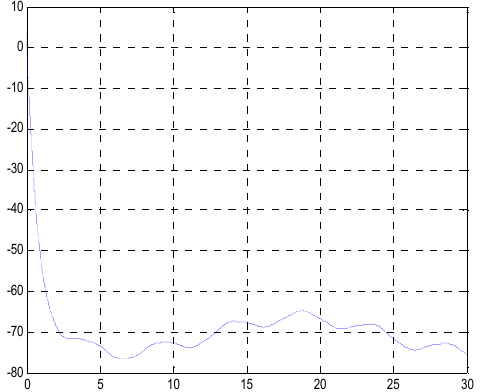
Figure 4. Power coe ffi cient.